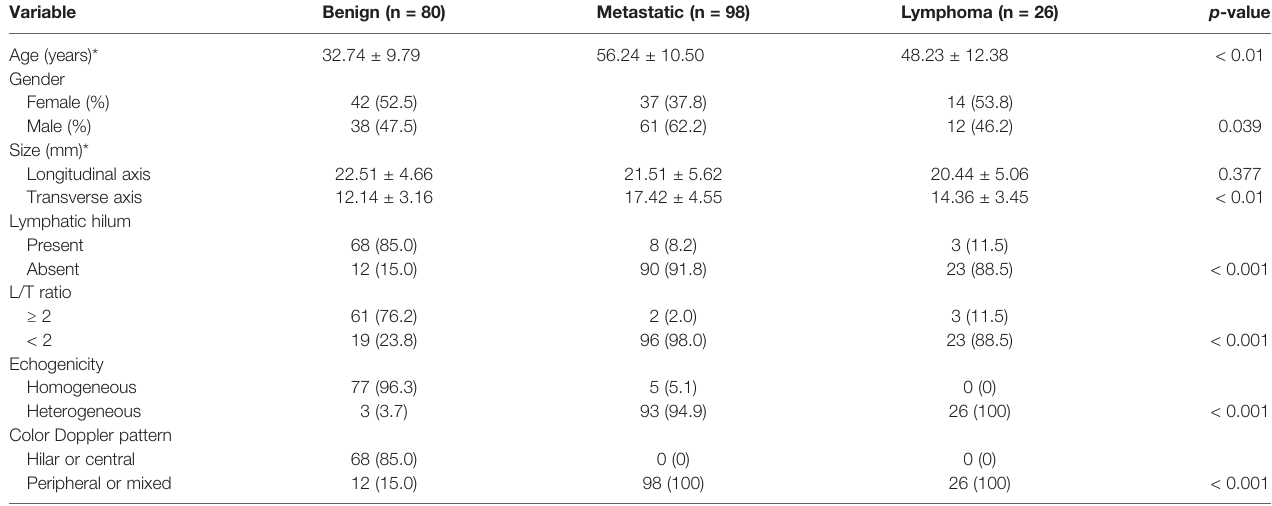
TABLE 1 | General data and conventional US characteristics of